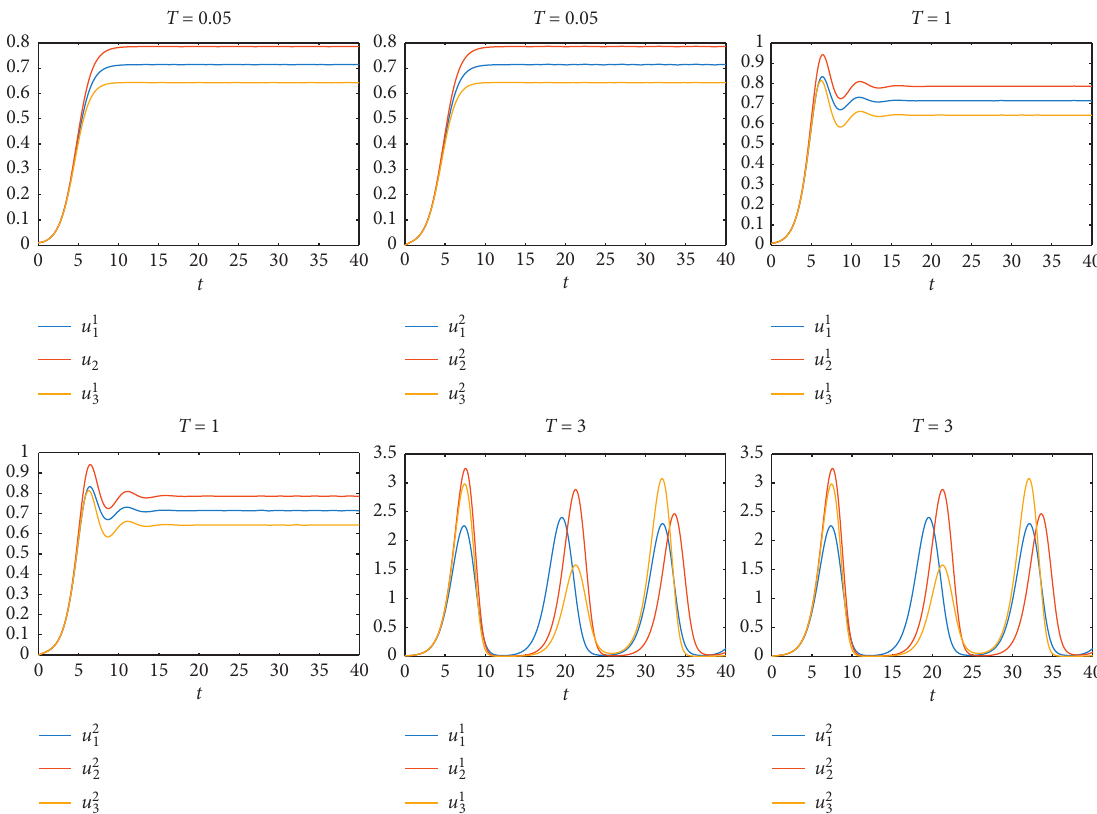
, d , d , d ) � ( 0 . 1 , 0 . 1 , 0 . 1 , 0 . 1 ) . 1 2 3 4